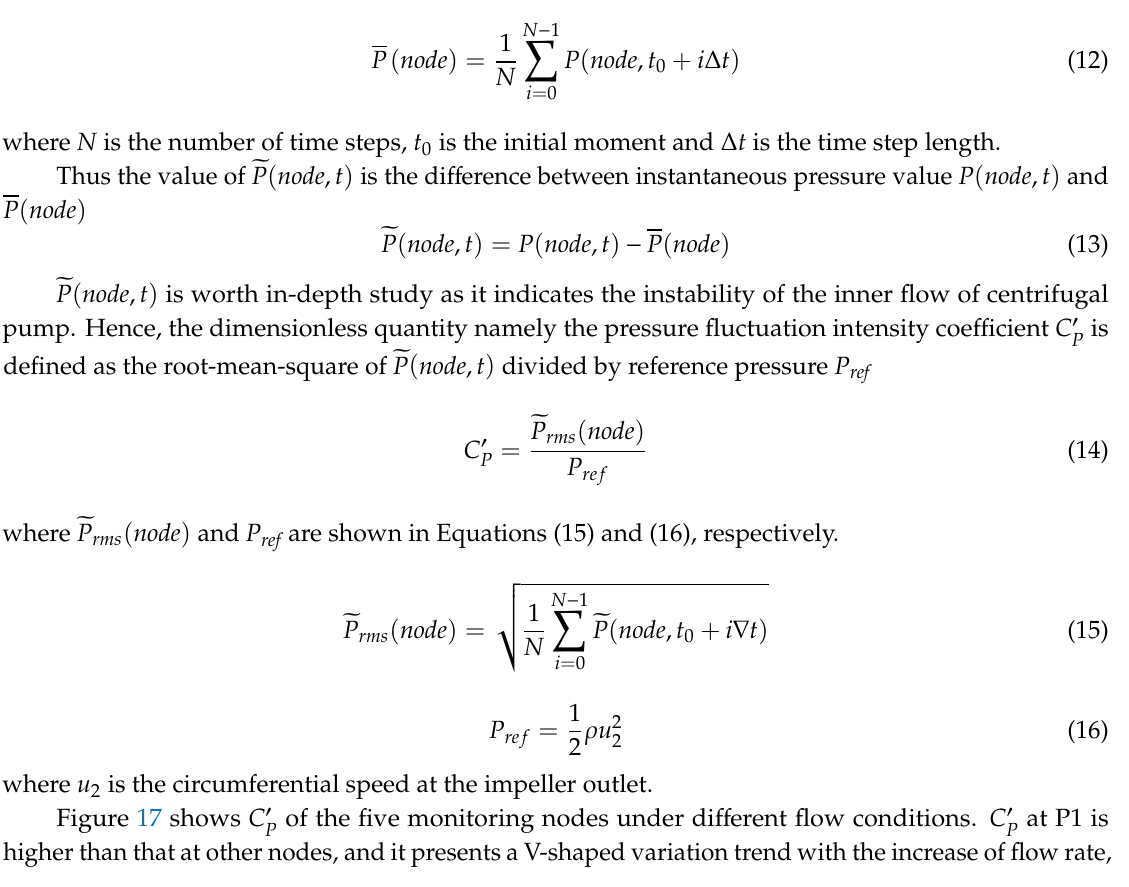
Figure 16. Pressure fluctuation of different monitoring points under Q des.